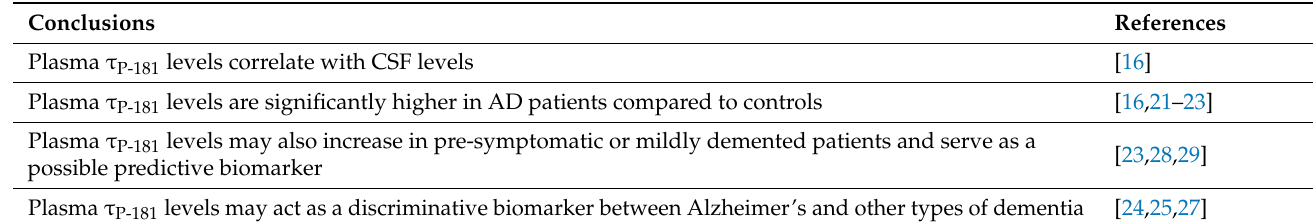
Table 1. The major conclusions of the latest studies concerning the role of plasma τ P-181 in the diagnosis of Alzheimer’s